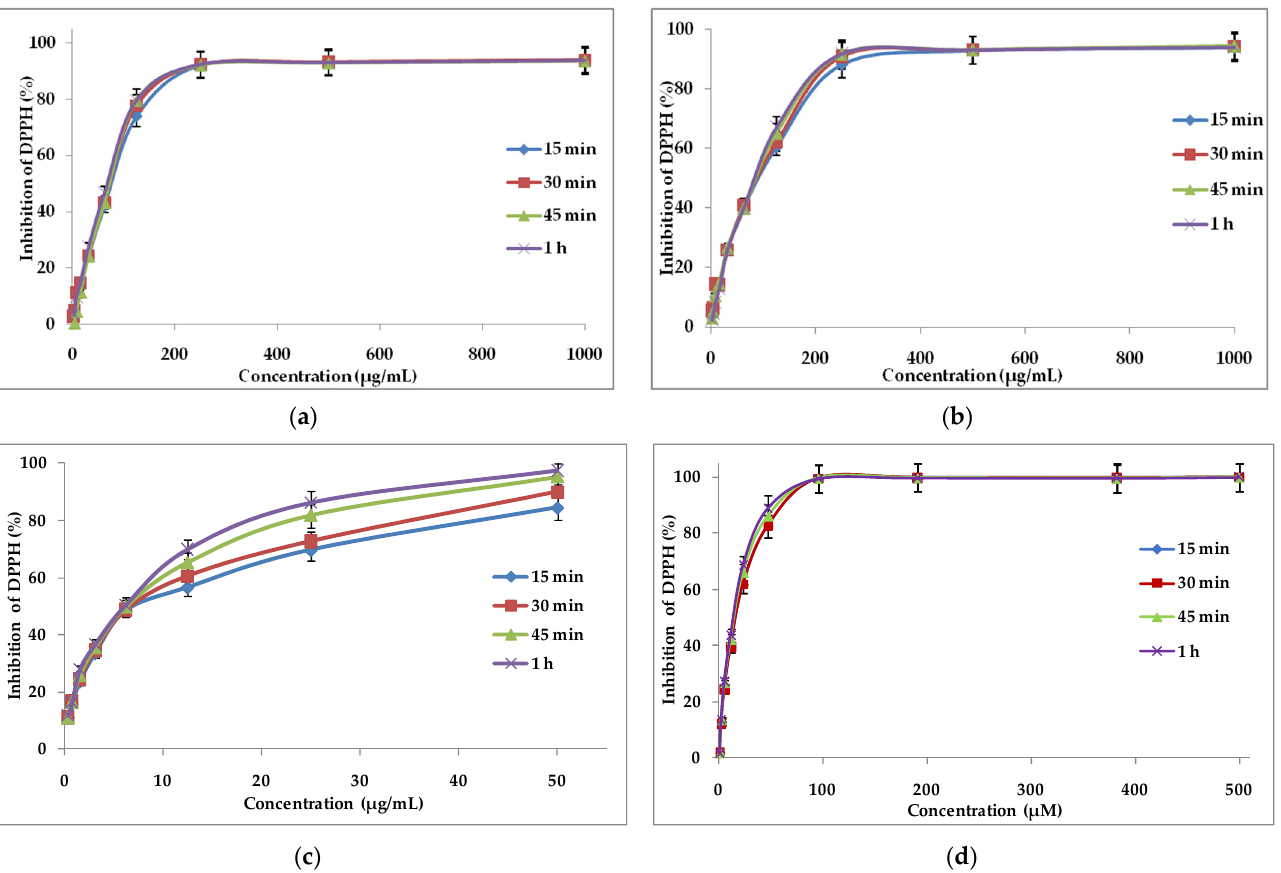
Figure 4. DPPH scavenging activity of ( a ) methanolic extract, ( b ) ethanolic extracts from A. foeniculum AdB, ( c ) EO from A. foeniculum AdB, and ( d ) gallic acid. Each value is the mean of three replicates ± SD.